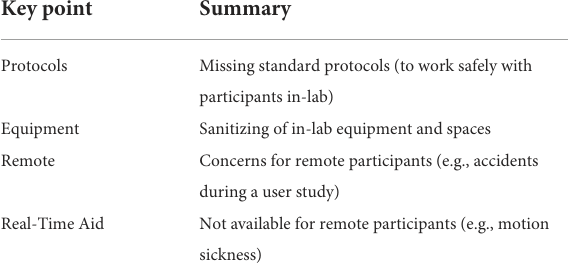
TABLE 5 Health and safety key